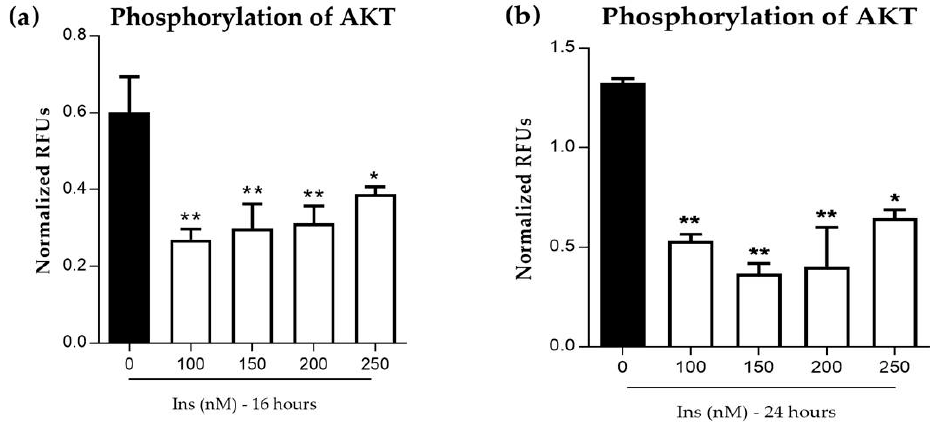
Figure 3. E ff ects of prolonged insulin induction with 100–250 nM concentrations on protein kinase B